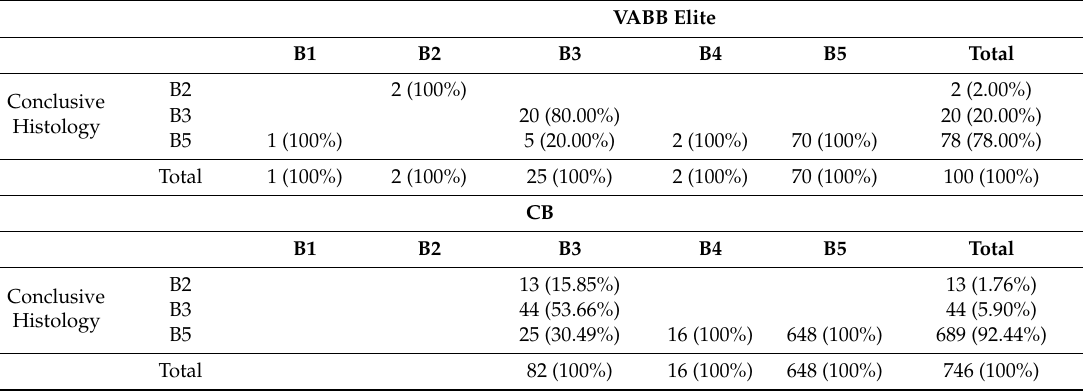
Table 2. Results of the Elite VABB (100 patients) and CB (746 patients) procedures as compared to the post-operative conclusive histological